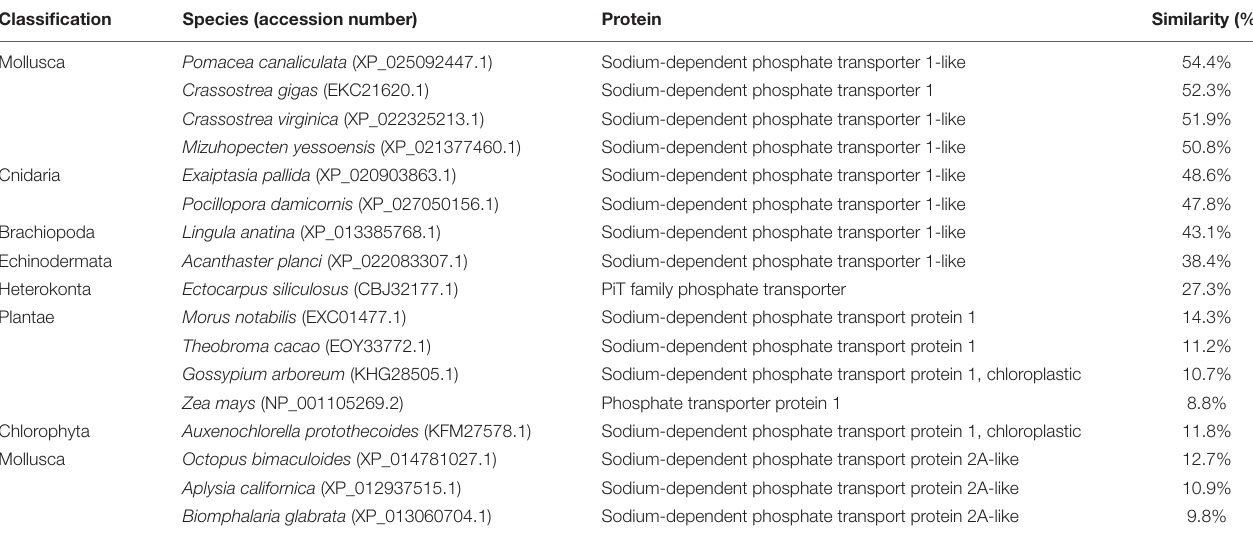
TABLE 1 | Percentage similarity of the deduced amino acid sequence of sodium-dependent phosphate transporter protein 1 (PiT1-like) obtained from T. squamosa and sodium-dependent transport proteins from other species obtained from GenBank.